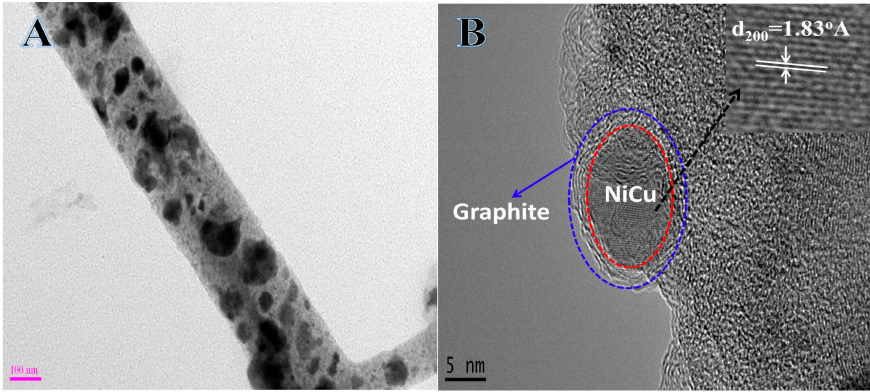
Figure 5. ( A ) TEM image of a single nanofiber and ( B ) high resolution TEM image.